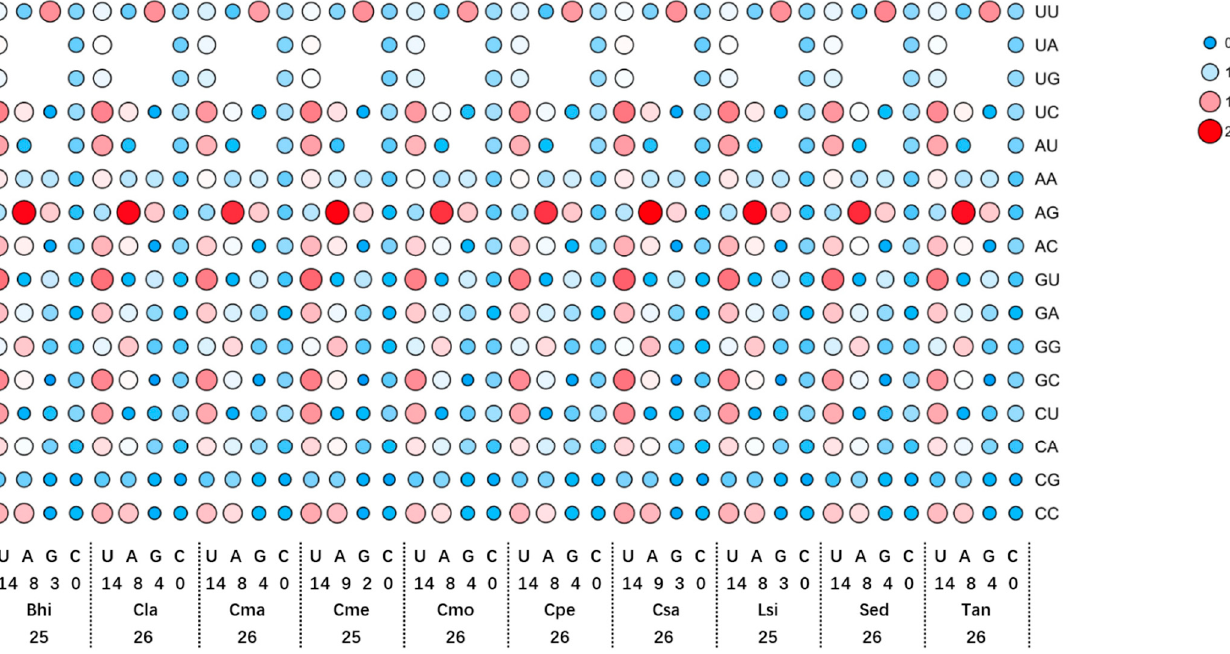
Figure 2. Heat map of relative synonymous codon usage (RSCU) values of ten species of Cucurbitaceae. Note: The vertical axis represents the first two bases of the codons, and the horizontal axis represents the third-base corresponding to each species. Abbreviations are used for species names (refer to Table 1 for details). The digits under UAGC represent the number of codons ending with corresponding bases with the RSCU value greater than one. The digits underneath the abbreviation of the species name represent the number of codons with the RSCU value greater than one in the related species. Blue to red color indicates low to high RSCU values. The blank spaces indicate three stop codons (UAA, UAG, and UGA) and two nonsynonymous codons (AUG and UGG). The size of circles also indicates the relative values of RSCU. This figure is drawn by TBtools software.